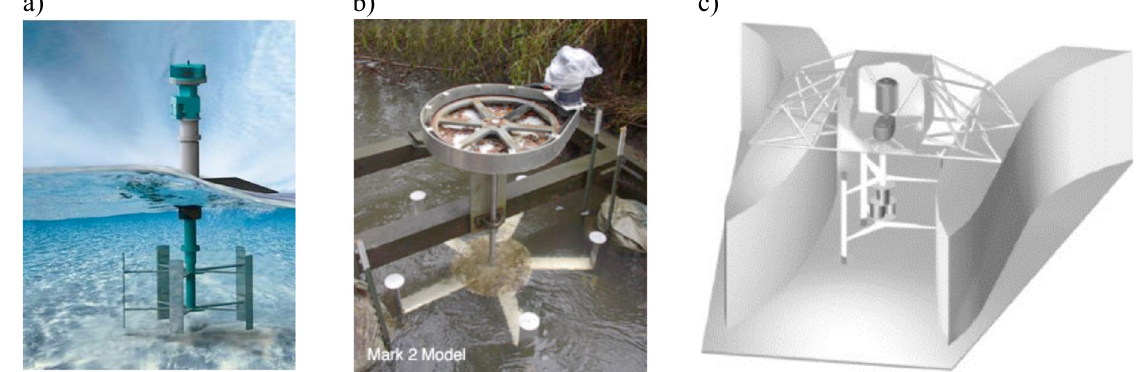
Figure 2: (i) the absolute reference frame, where Cartesian coordinates X , Y or cylindrical coordinates can be used; (ii) the reference frame relative to the fl ow, with axes respectively aligned with the direction of the relative velocity and orthogonal to this direction, in which the hydrodynamic force applied by the fl uid to the blade is decomposed into the drag D and lift L components; (iii) the reference frame relative to the blade, with axes respectively tangential and normal to the turbine rotation center, in which the hydrodynamic force is decomposed into a normal